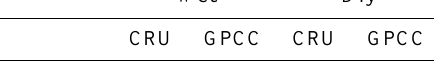
Table 3. The proportion of ET trends explained by all predictor vari- ables and precipitation only (expressed as R 2 ) across wet and dry basins, using CRU- and GPCC-based ET and precipitation, respec- tively. Wet Dry CRU GPCC CRU GPCC All variables Precipitation 45%